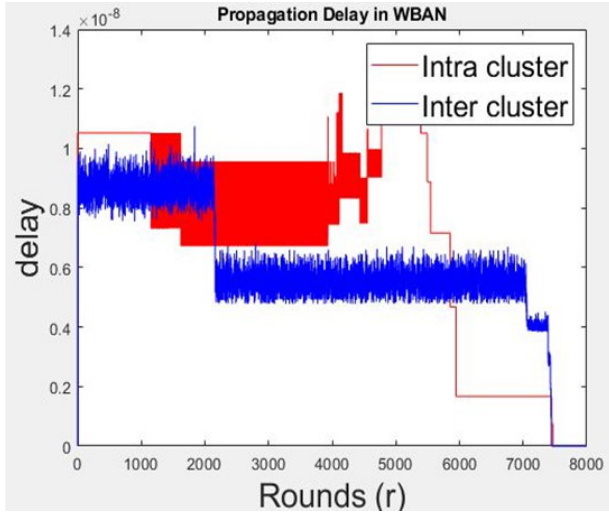
Figure 13. Propagation delay in WBAN